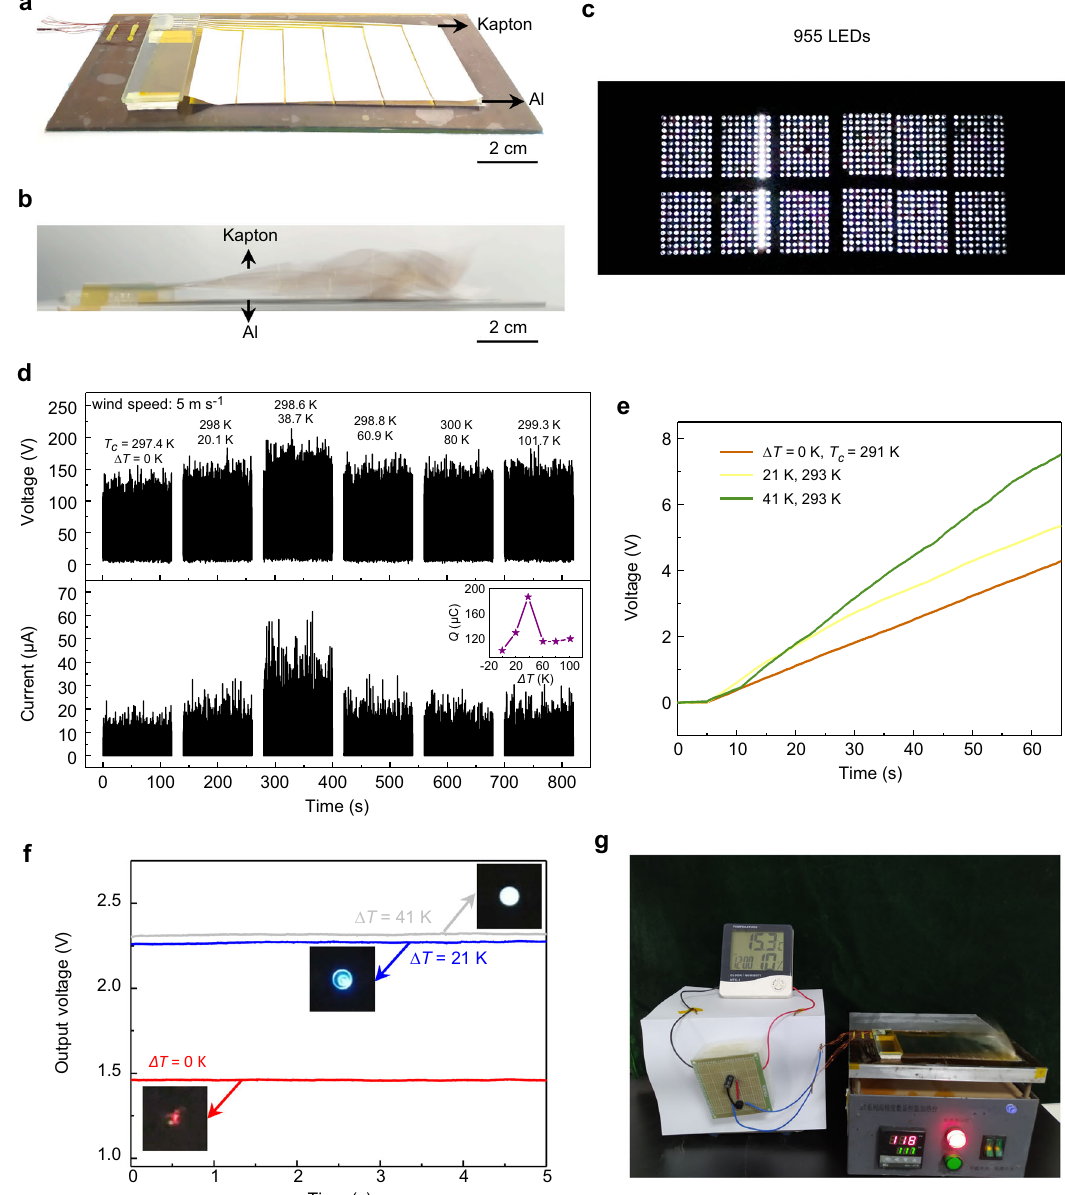
Fig. 5 Demonstration of the wind-driven TDNG working on the surface of high temperature object. a The optical image of the wind-driven TDNG. b The optical image of a working wind-driven TDNG under the wind. The Al foil is fl attened against the thermostat heater serving as a hotter part, and the Kapton fl ag is swaying in the air serving as a cooler part. c 955 white LEDs are lightened by a wind-driven TDNG under a wind speed of ~8.3 m s − 1 . d The open- circuit voltage and the short-circuit current of the wind-driven TDNG under different Δ T (wind speed: 5 m s − 1 ). e Charging curves of a capacitor with 22 μ F capacitance by wind-driven TDNG under different Δ T (0 K (brown line), 21 K (yellow line), 41 K (green line)). f LEDs are used for temperature difference indicator. g The optical image of a temperature-humidity sensor powered by wind-driven